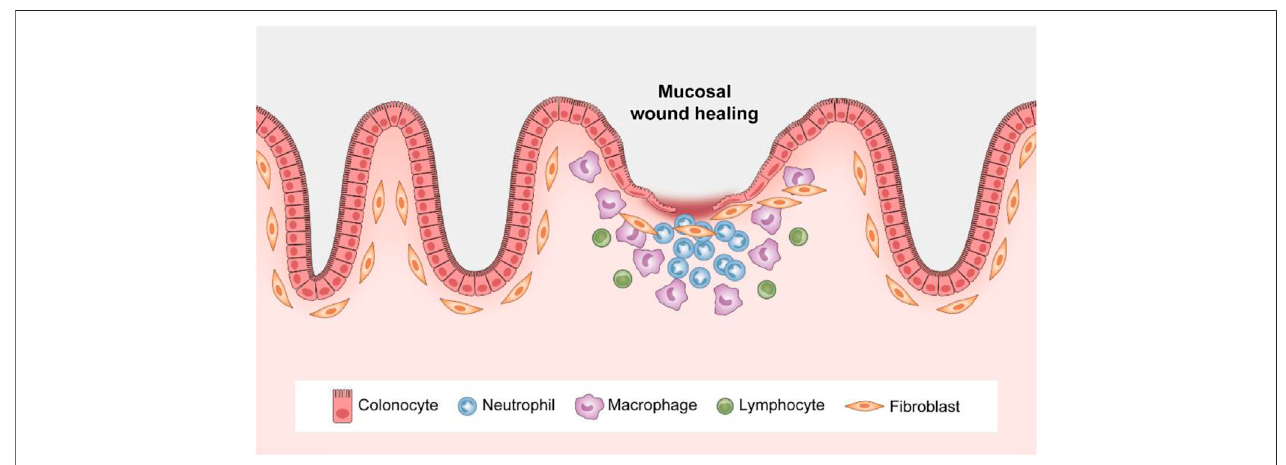
FIGURE 3 | Spatiotemporal control of wound repair. After mucosal injury, neutrophils rapidly accumulate at the wound site, followed by an increased presence of macrophages. Epithelial restitution is achieved by epithelial cell migration and subsequent proliferation.